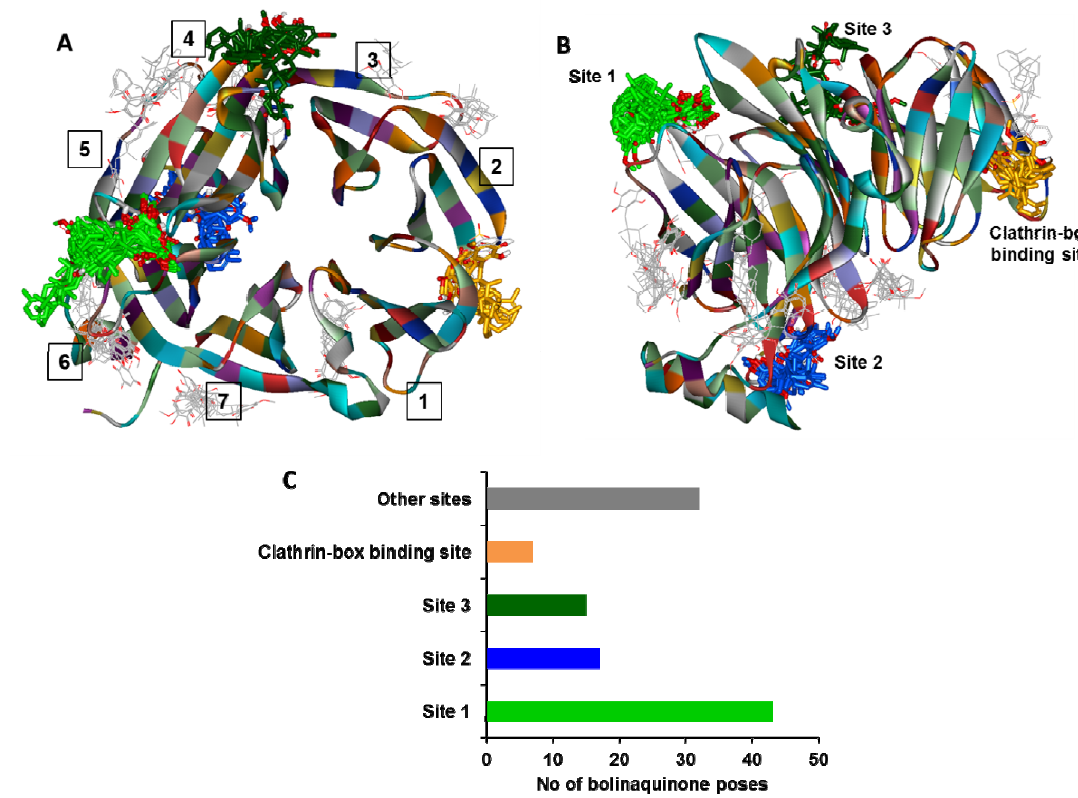
Figure 2. ( A ) Ribbon representation of a top view of the CTD (2XZG). The positioning of each of the seven β -stranded blades is indicated by the numbers 1-7. The predicted binding clusters for the docked 1 poses are rendered in stick representation and are color coded (non-carbon atoms) with orange (clathrin-box binding site), green (site 1), blue (site 2) and dark green (site 3). ( B ) Same representation as in A rotated 90° inward, indicating potential 1 binding sites. ( C ) Bar graph representation of the number of 1 poses in each binding site cluster shown in A and B . The bar colors correspond to the binding sites and 1 -clusters identified in A and B